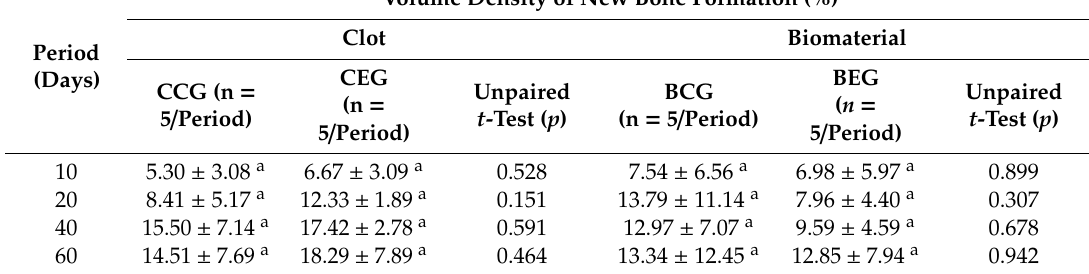
Table 4. Mean ± standard deviation of volume density of new bone formation Comparison between same treatment per animal condition (non-alcoholic and alcoholic). Unpaired t-test (line, CCG vs. CEG and BCG vs.